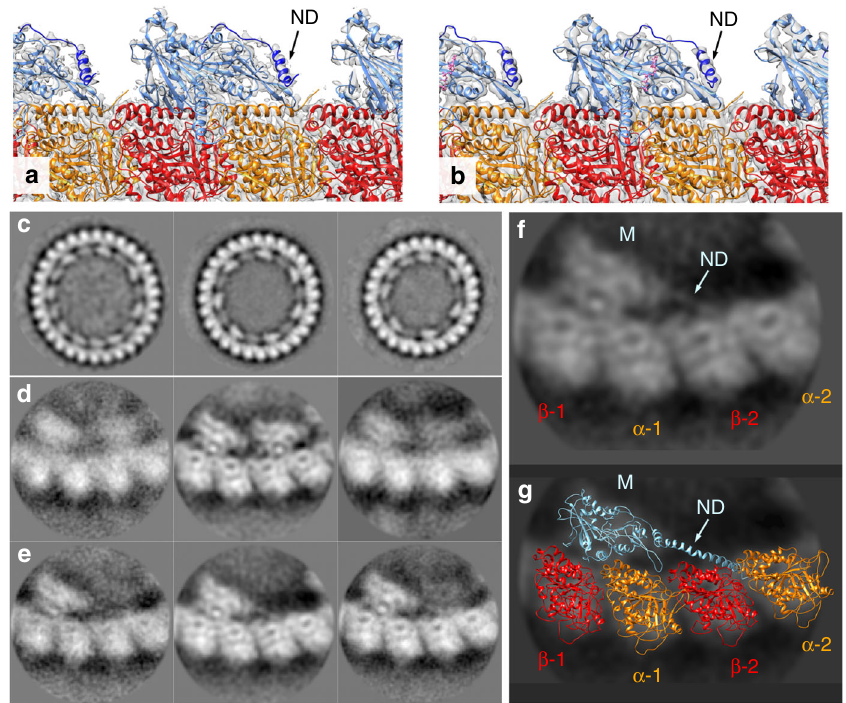
Fig. 5 Con fi guration of the KLP10A neck domain. a, b Structure of the neck domain (ND) in the NMMT complexes. a NMMT apo . b NMMT AMP-PNP . c Class averages of curved tubulin proto fi laments obtained by aligning and classifying whole ring-like structures observed in cryo-EM images (Supplementary Fig. 1d). d, e Class averages of curved tubulin proto fi laments obtained by aligning/classifying regions containing two tubulin heterodimers from the classes shown in c . This classi fi cation produced class-averages with one KLP10A motor domain per tubulin heterodimer ( d ) and class averages with one KLP10A motor domain per two tubulin heterodimers ( e ). f In the class average images with only one KLP10A motor domain per two tubulin heterodimers, an elongated density can be observed going from the motor domain density (M) to the density corresponding to the next tubulin heterodimer ( α -2, β 2). g The elongated density in f is modeled as an α -helix formed by the KLP10A neck-domain